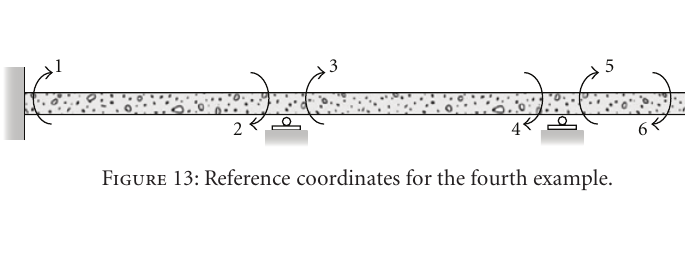
Figure 12: Section properties for the fourth example.